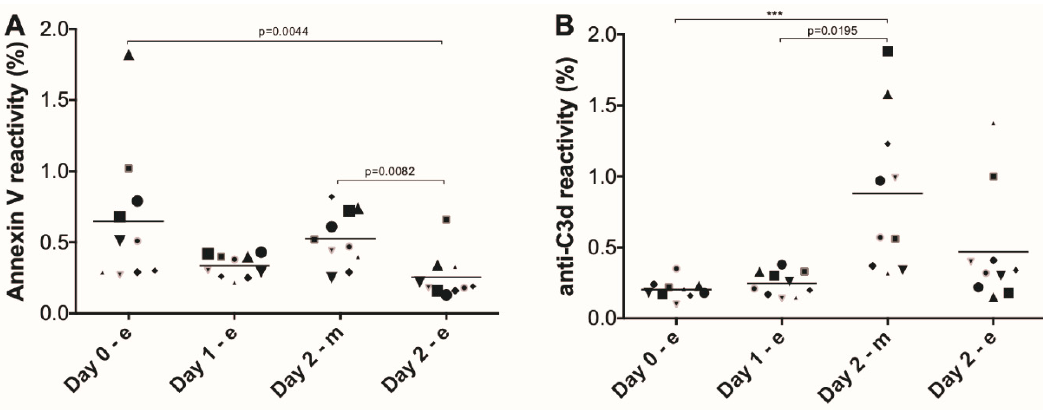
Figure 2. Appearance of removal signals on red blood cells during the Nijmegen Four Days Marches. ( A ) The fraction of phosphatidylserine (PS)-exposing red blood cells (RBCs) as determined using fluorescent annexin V; ( B ) the fraction of C3d-positive RBCs, as determined with a fluorescent monoclonal antibody, as described in Materials and Methods. Each symbol represents an individual. Significant differences: ***, p < 0.001; **** (N = 10). The fraction of the most mature reticulocytes, as detected by the fraction of CD71-positive RBCs [20], decreased after the first day of marching, but increased again during the consecutive night (Figure 3).